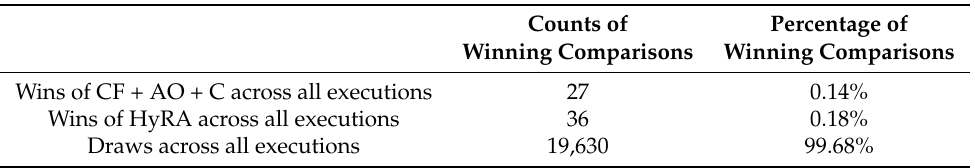
Table 12. Comparison between the user-based CF with an average aggregation operator + the Smart POIs’ categories and HyRA.